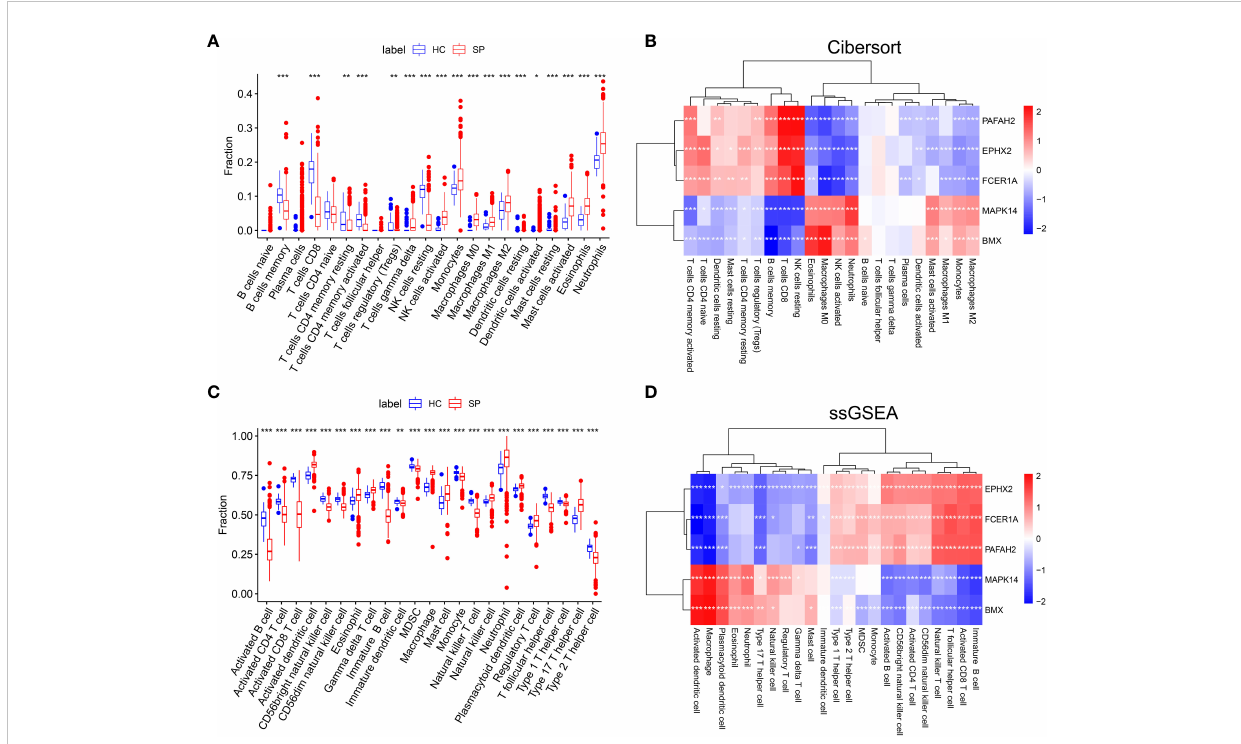
FIGURE 4 The landscape of Immune cell in fi ltration and correlation analysis in GSE65682. (A) Analysis of immune-cell proportion comparisons between sepsis patients and healthy controls by CIBERSORT. (B) Person ’ s correlation analysis of CIBERSORT between in fi ltrating immune cells and identi fi ed hub genes. Red nodes indicate positive correlation while blue nodes indicate negative correlation. (C) Analysis of immune-cell proportion comparisons between sepsis patients and healthy controls (The blue and red boxplots stand for control and sepsis, respectively) by ssGSEA. (D) Person ’ s correlation analysis of ssGSEA between in fi ltrating immune cells and identi fi ed hub genes. Red nodes indicate positive correlation while blue nodes indicate negative correlation. *: as compared with the Control group, P < 0.05; **: as compared with the Control group, P <0.01; ***: as compared with the Control group, P